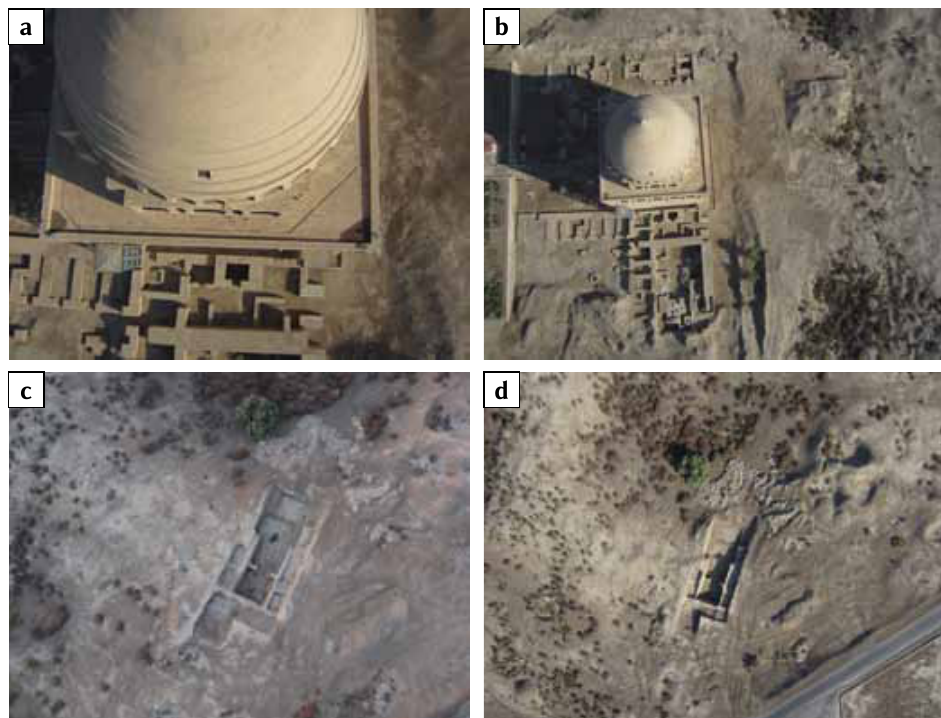
Fig. 11: The difference between the 2cm/pixel resolution ( a & c ) and the 4cm/pixel resolution ( b & d ); images at the top of the mausoleum of Sultan Sanjar, and at the bottom of an excavation trench